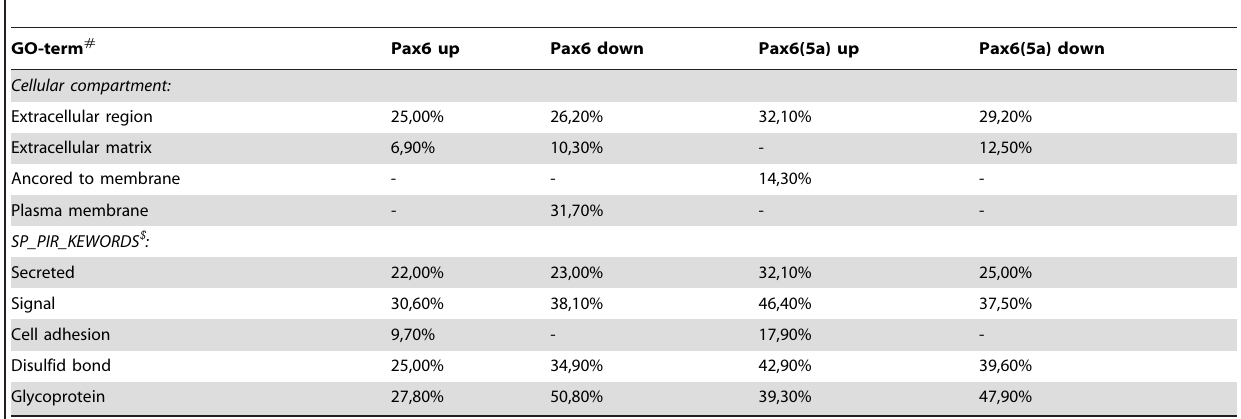
Table 2. Percentage of Pax6/Pax6(5a) up- or downregulated genes associated with Gene ontology (GO) terms ‘‘Cellular compartment’’ and